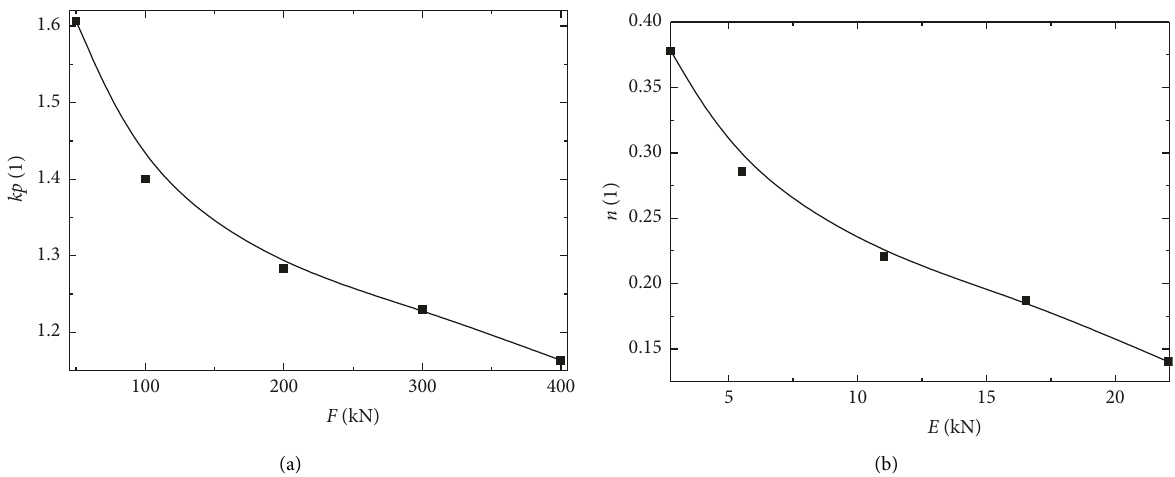
Figure 3: Variations of crushing expansion coefficient and porosity with load. (a) Crushed compaction expansion coefficient with load. (b) Variation of porosity with stress.